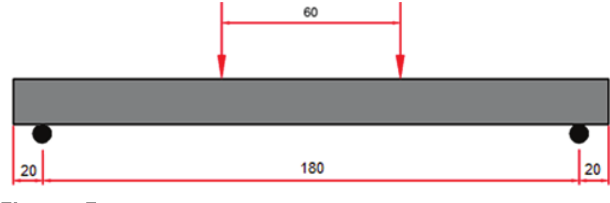
Figure 5 Arranjo de ensaio de vigas submetidas à flexão em quatro pontos (medidas em